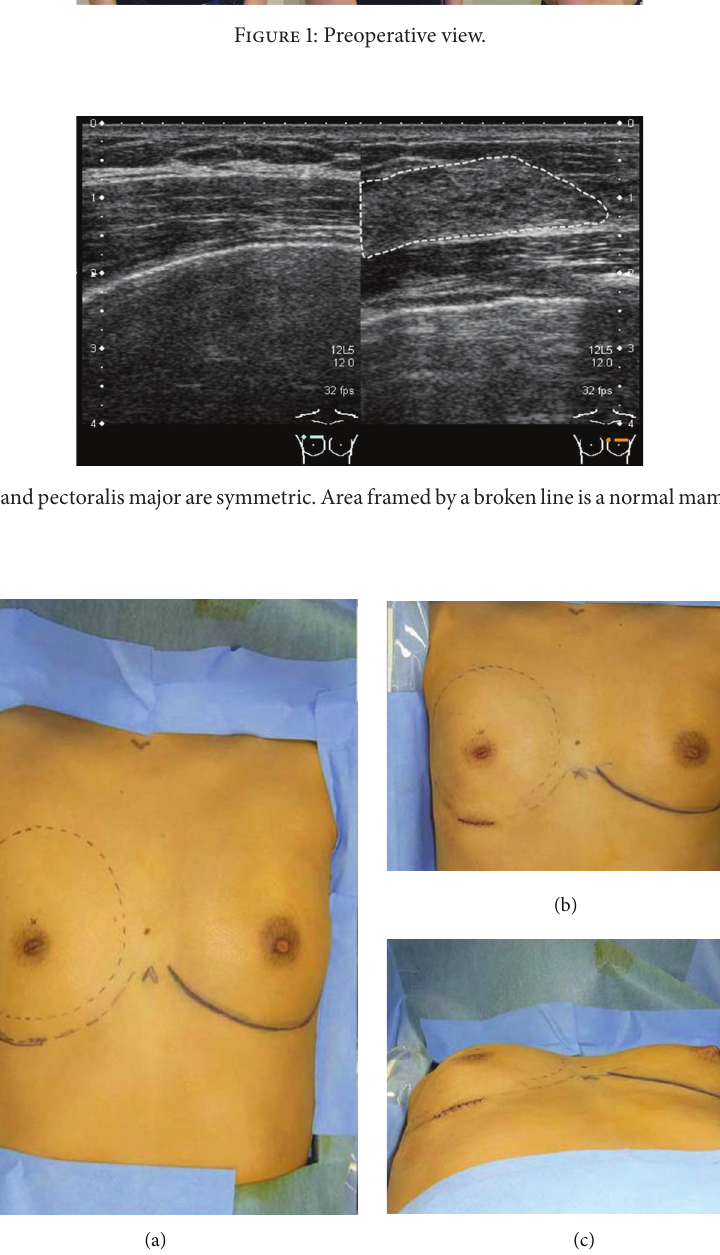
Figure 3: Preoperative view: (a) The quantity of skin was insufficient in the area above the nipple on the affected side. The center of the inserted tissue expander was positioned 2cm above the nipple. Postoperative view: (b) Incision was 4cm long and positioned at the expected inframammary fold after reconstruction. A tissue expander was inserted into the submuscular layer. Initial volume of the tissue expander was 50mL